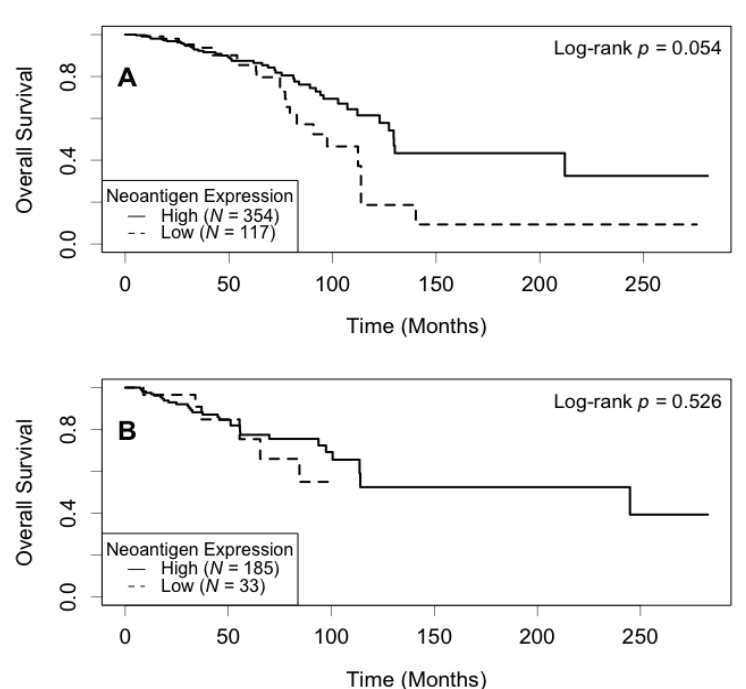
Figure 4. Kaplan–Meier survival curve of neoantigen expression stratified by PR status. ( A ) In the PR positive subgroup, patients with a high level of neoantigen expression had borderline better overall survival compared to those with a low level ( p = 0.054); ( B ) In the PR negative subgroup, there was no significant difference between patients in the high and low levels of neoantigen expression ( p = 0.526).